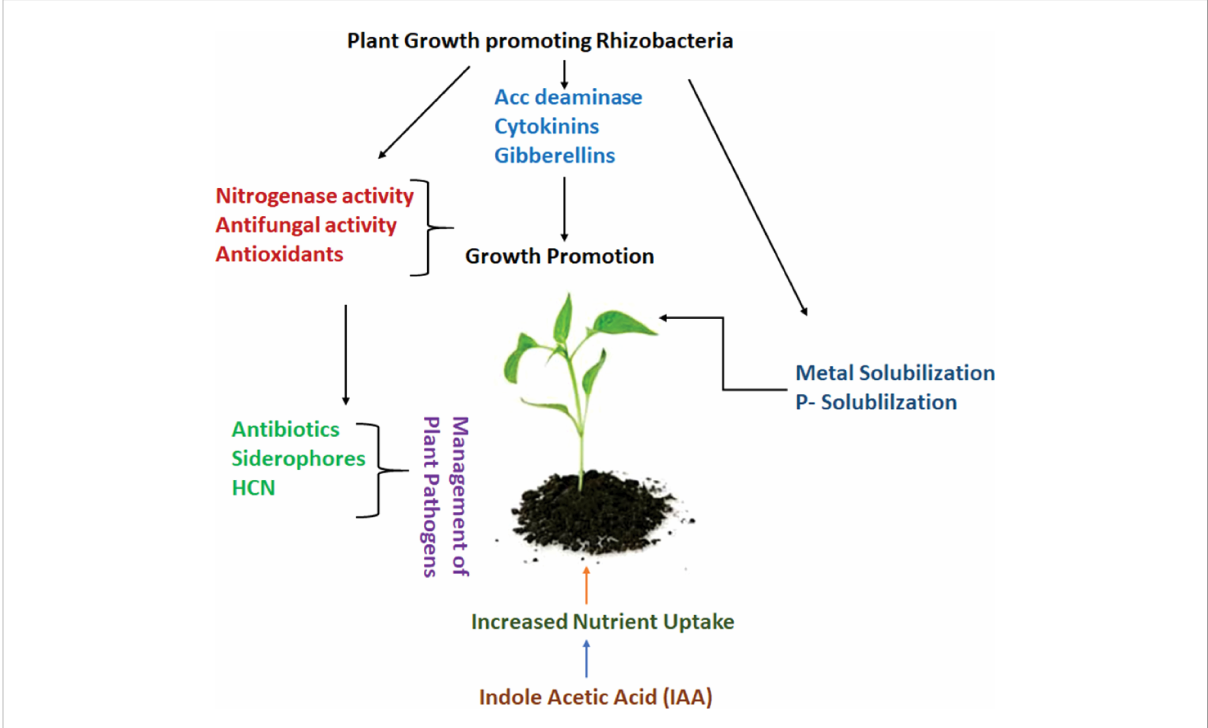
FIGURE 3 Mechanism of plant growth promotion by rhizobacteria